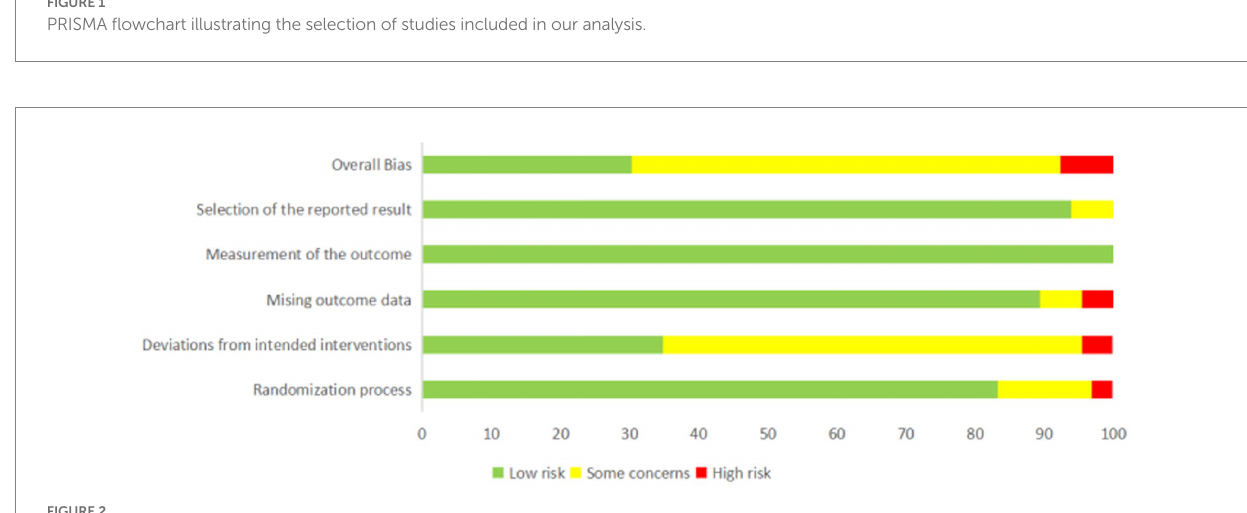
FIGURE 2 Risk of bias graph for each included